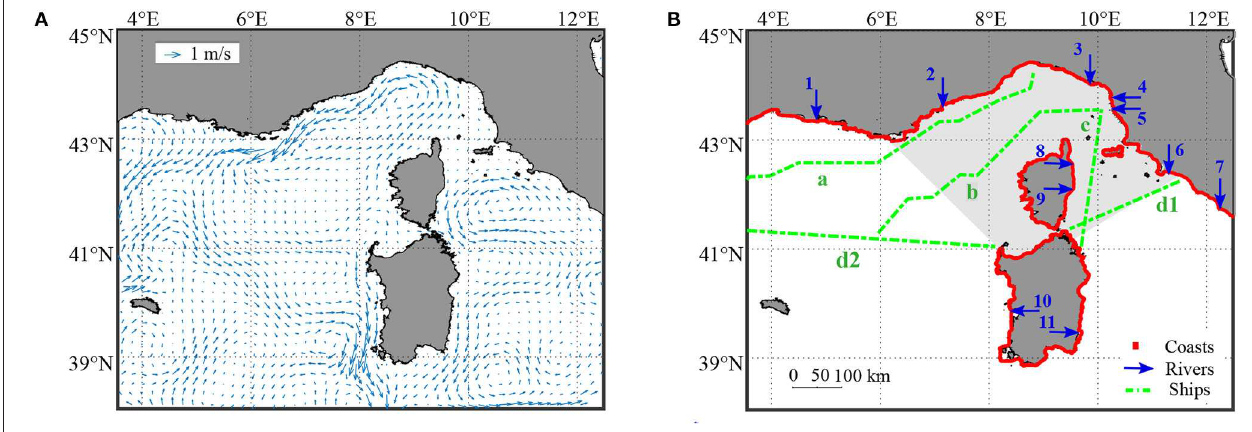
FIGURE 1 | Input data used to assess the hazard component of the risk maps via numerical simulations. (A) Surface circulation fields in the simulated summer seasons (averaged over the time horizon 2000–2010), as obtained from reanalysis data. (B) Geographic displacement of particle sources used in the simulations. The Pelagos Sanctuary is shaded in gray. Coastline release sites are colored in red. Blue arrows indicate the mouths of the major rivers flowing directly into the simulation domain and have been numbered from West to East: 1. Rhone, 2. Var, 3. Magra, 4. Serchio, 5. Arno, 6. Ombrone, 7. Tevere, 8. Tavignano, 9. Golo, 10. Tirso, 11. Flumendosa. Green dash-dotted lines indicate the main shipping lanes: a. Genova-Barcelona, b. Livorno-Barcelona, c. Livorno-Olbia, Civitavecchia-Barcelona eastern (d1.) and western (d2.)